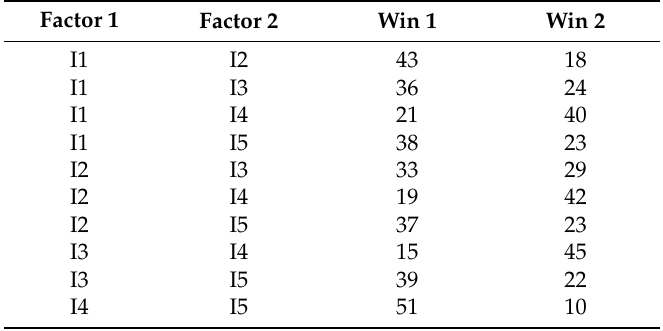
Table 9. Input file of Internal (I) factors preferences in a win-to-loss context.